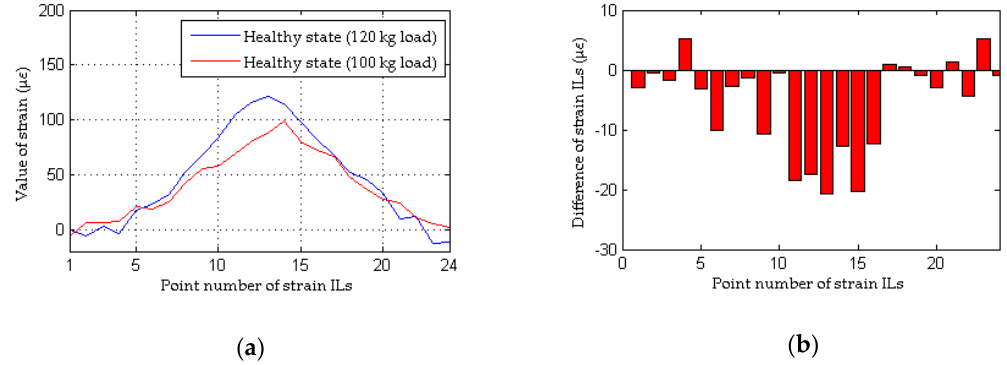
Figure 21. Results of the traditional method for the model bridge considering the effect of loading condition: ( a ) strain ILs at point #13 of the #1 beam for experimental case 1 and experimental case 3; ( b ) difference in the strain ILs at point #13 between before and after damage for experimental case 3.